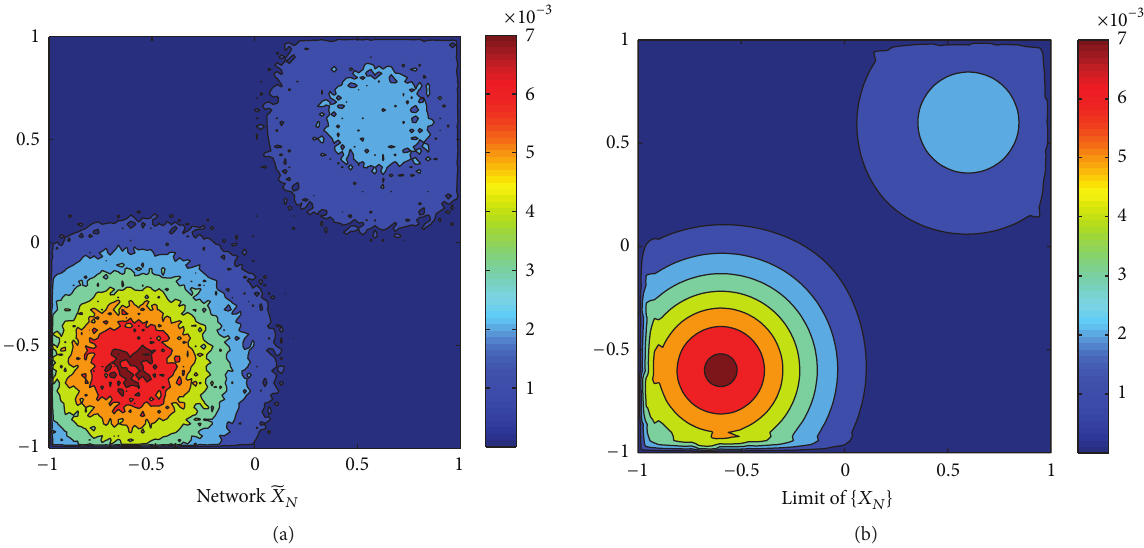
Figure 9: The comparison of the 2D controlled network and the location-invariant continuum limit at 𝑡 = 1